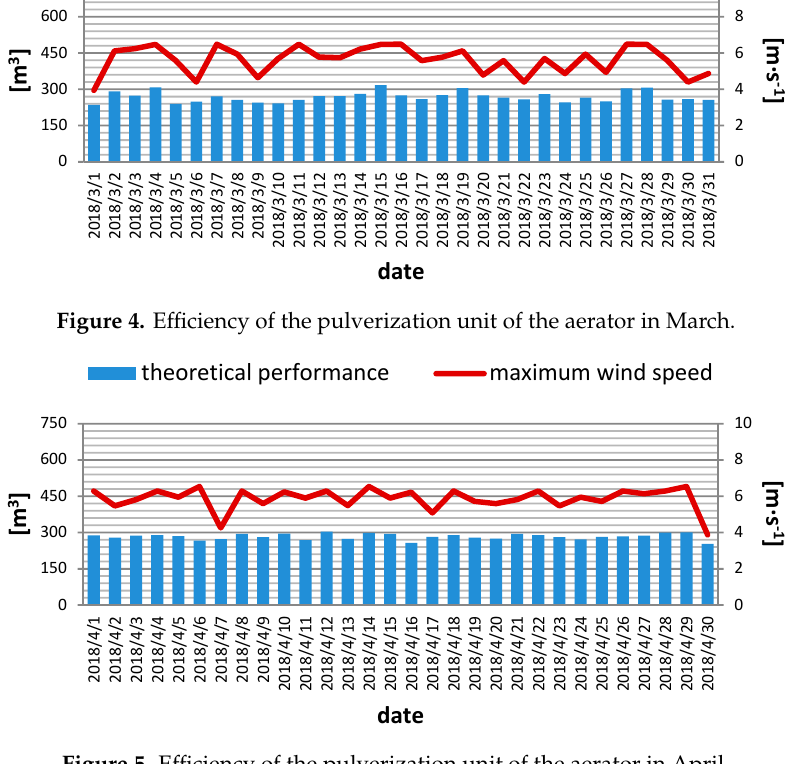
Figure 4. Efficiency of the pulverization unit of the aerator in March.